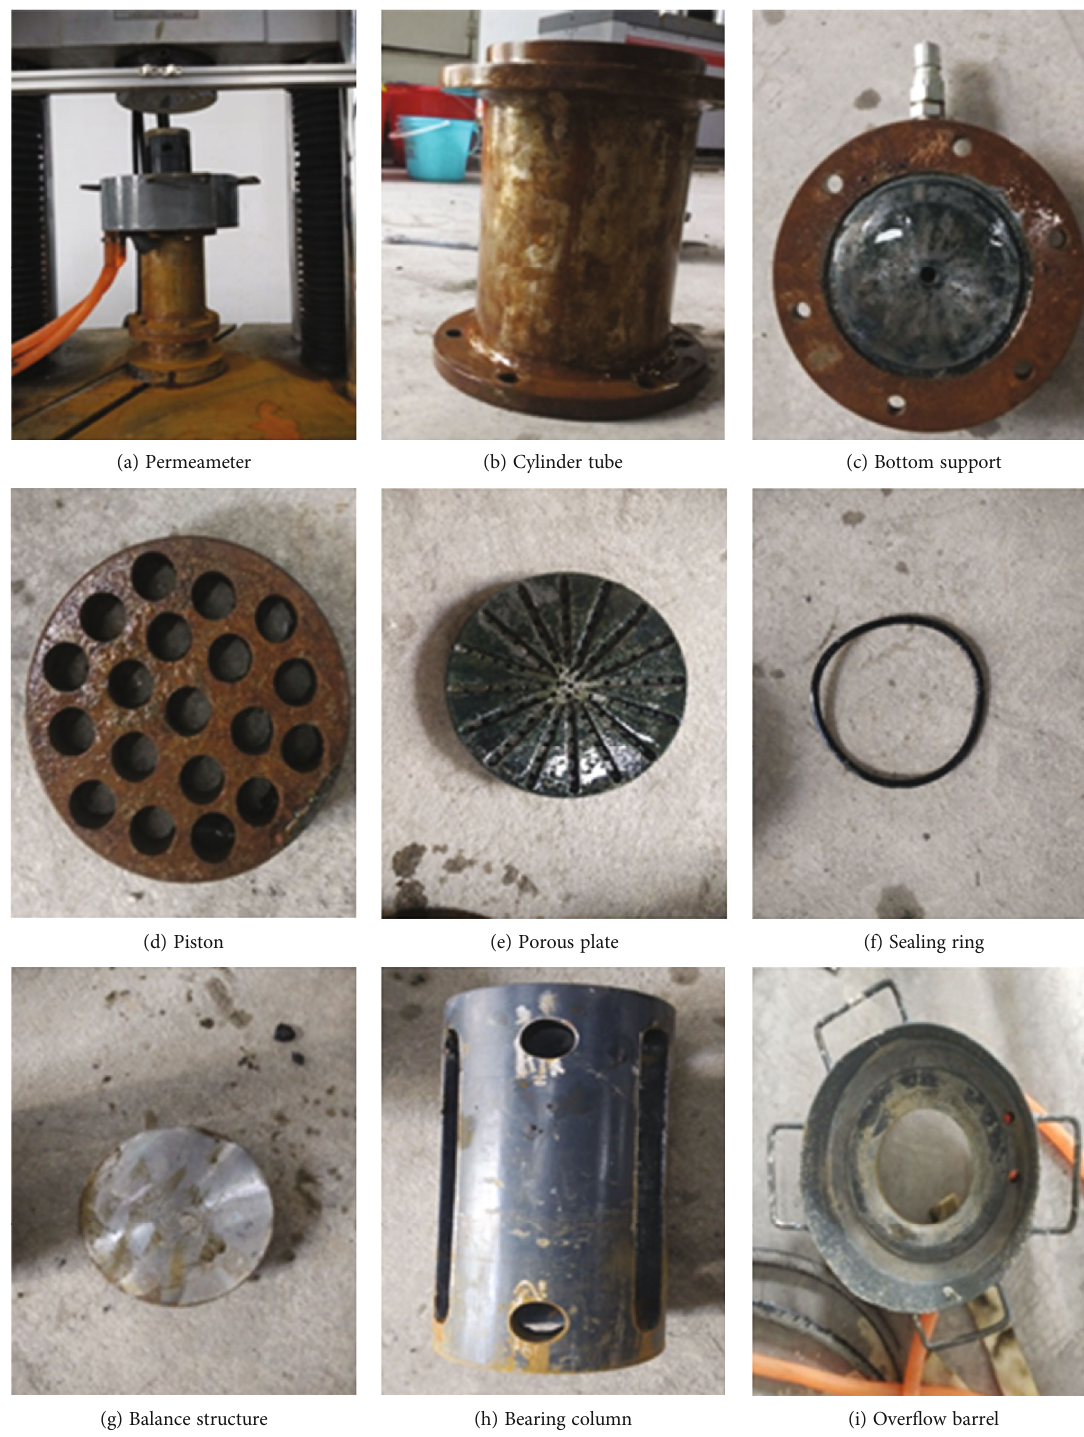
Figure 3: Picture of the experimental seepage